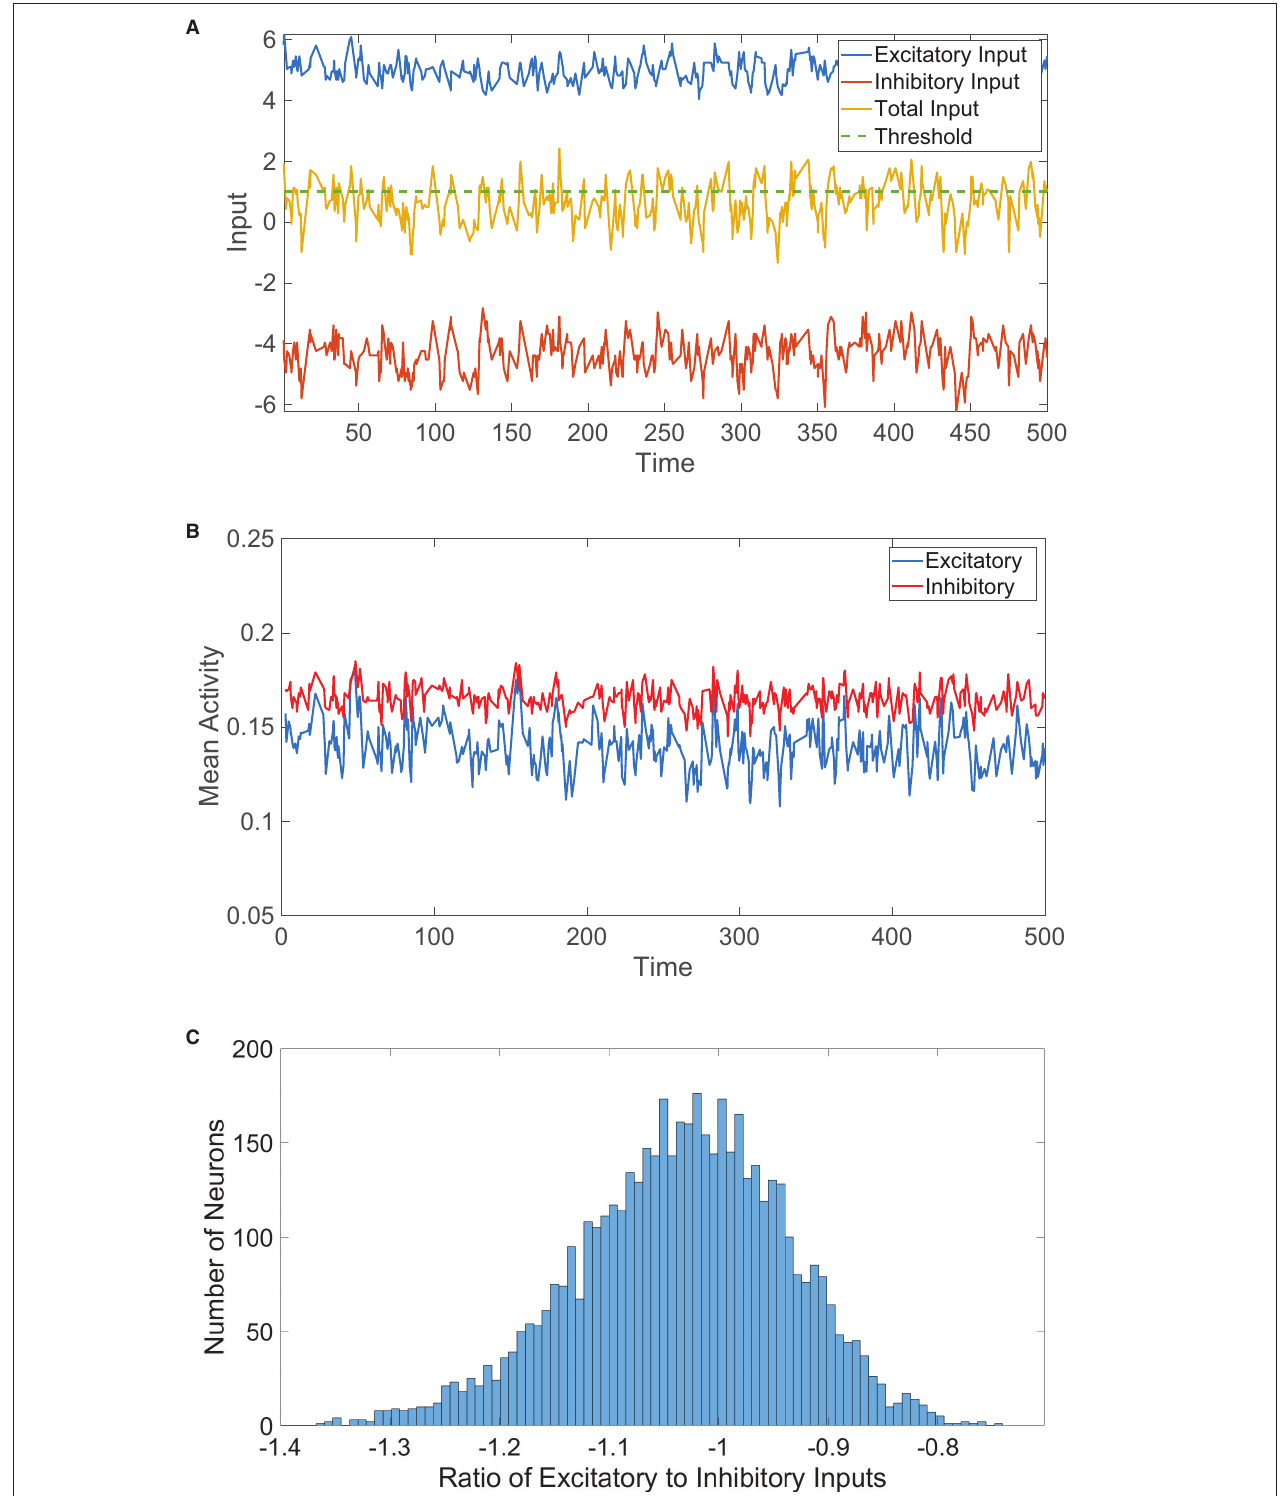
FIGURE 1 | Two-population balanced network dynamics. (A) Excitatory (blue), inhibitory (red), and net (yellow) inputs into a sample excitatory neuron in a two-population balanced network. The dashed (green) line indicates the firing threshold. (B) The population-averaged state (mean activity) of the excitatory (blue) and inhibitory (red) populations as a function of time. (C) Histogram of the ratio between time-averaged excitatory and inhibitory inputs across the two-population neuronal network. Parameters utilized are J EE